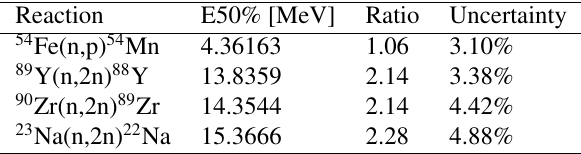
Table 1. Comparison of 252 Cf SACS measured in this work with data calculated using IRDFF-1.05.